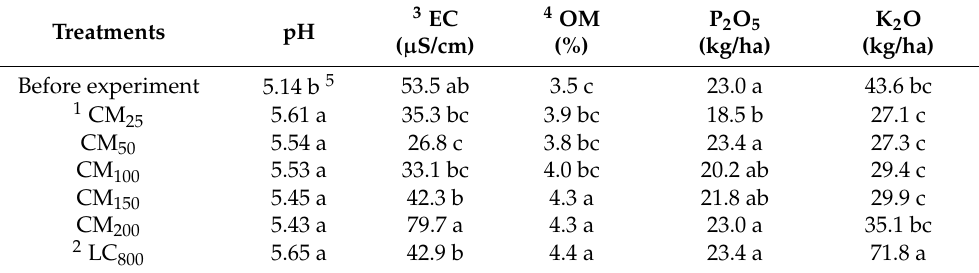
Table 1. The soil properties before and after treatments of different rate of organic fertilizer. Treatments Before